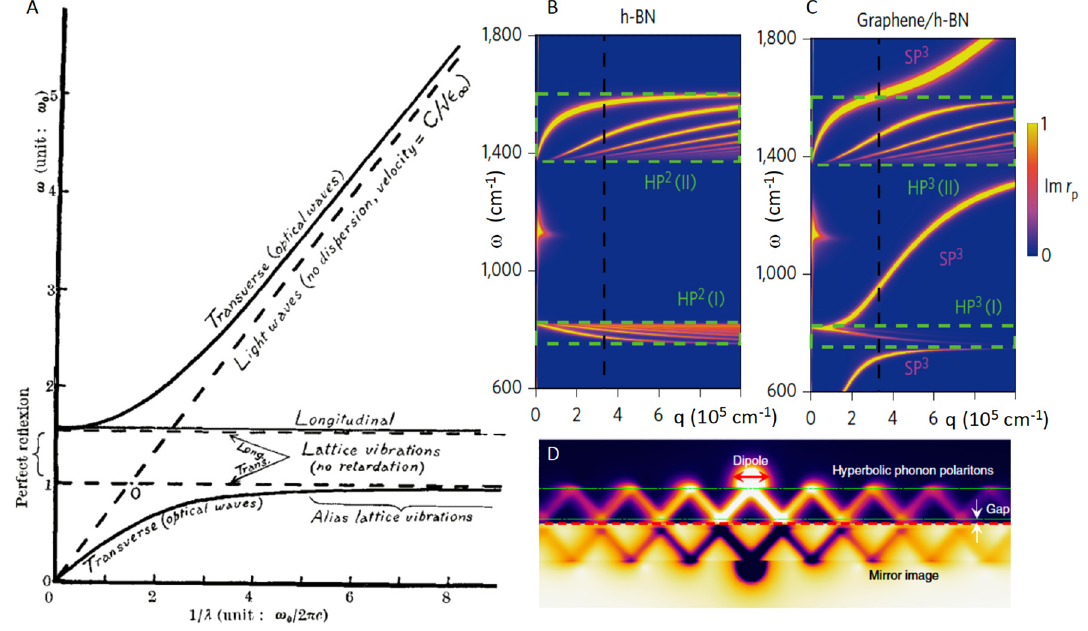
Figure 5: Phonon polaritons, hybrid plasmon – phonon polaritons, and image polaritons. PanelA: dispersion of phononpolaritonsinionic crystalspredicted byHuang (ina study by Sunetal. [175]).In theoriginal publication, Huang didnotusethetermpolariton.PanelB:calculateddispersionofthehyperbolicphononpolaritonsinhBN(HP2).PanelC:calculateddispersion of the hyperbolic phonon polaritons in h-BN coupled to plasmon polaritons in the graphene layer and forming hyperbolic plasmon – phonon polaritons (HP3) and surface plasmon – phonon polaritons (SP3). Adapted from a study by Bezares et al. [212]. Panel D: concept of image polaritons at the interface of hBN and a metal. From a study by Yoo et al.